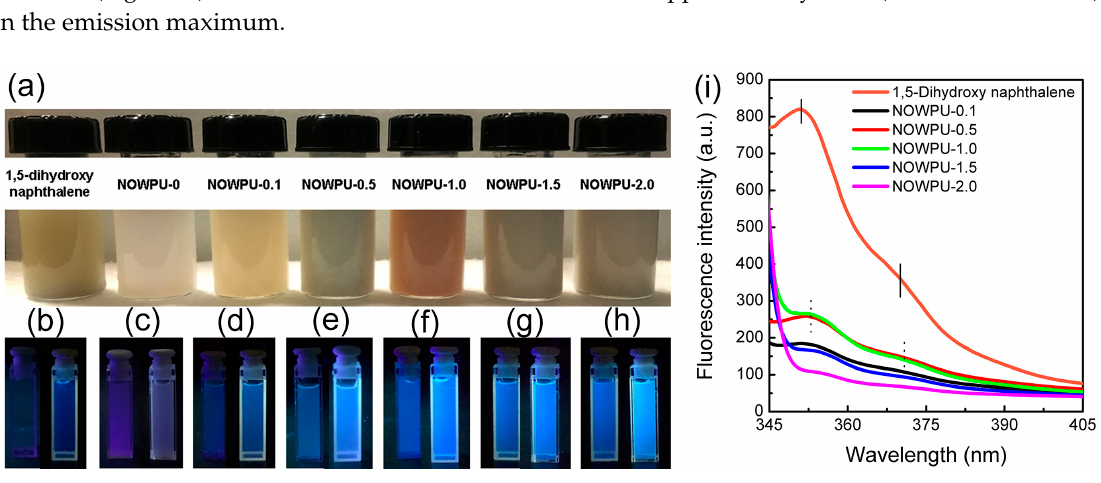
Figure 3. ( a ) Photographs of NOWPUs by natural; and ( b ) to ( h ) UV light; and ( i ) fluorescence emission spectrum of NOWPUs: the left of ( b ) to ( h ) was radiated at 254 nm UV lamp, the right of ( b ) to ( h ) was radiated at 365 nm UV lamp (The samples for natural light were original emulsion, concentration of NOWPUs for UV lamp = 10 − 3 g/mL in water).